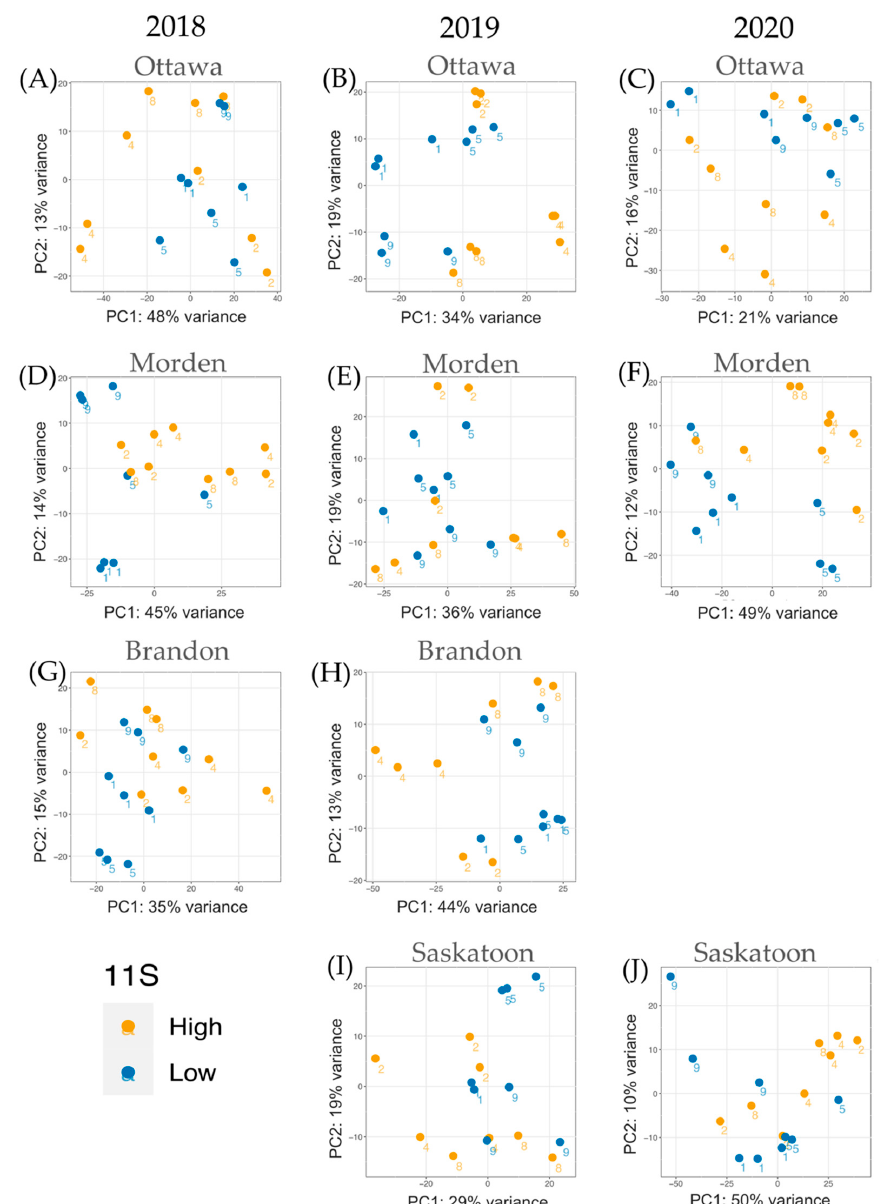
Figure 3. PC analysis of normalized RNA-seq expression data for samples included in each individual DE analysis across the four locations and three years. Each 11S year-location dataset is represented: ( A ) Ottawa 2018, ( B ) Ottawa 2019, ( C ) Ottawa 2020, ( D ) Morden 2018, ( E ) Morden 2019, ( F ) Morden 2020, ( G ) Brandon 2018, ( H ) Brandon 2019, ( I ) Saskatoon 2019, ( J ) Saskatoon 2020. Orange datapoints represent high 11S samples, blue datapoints represent low 11S samples. No data for Saskatoon 2018 and Brandon 2020. The line number (1, 2, 4, 5, 8, 9) for each corresponding datapoint is indicated.